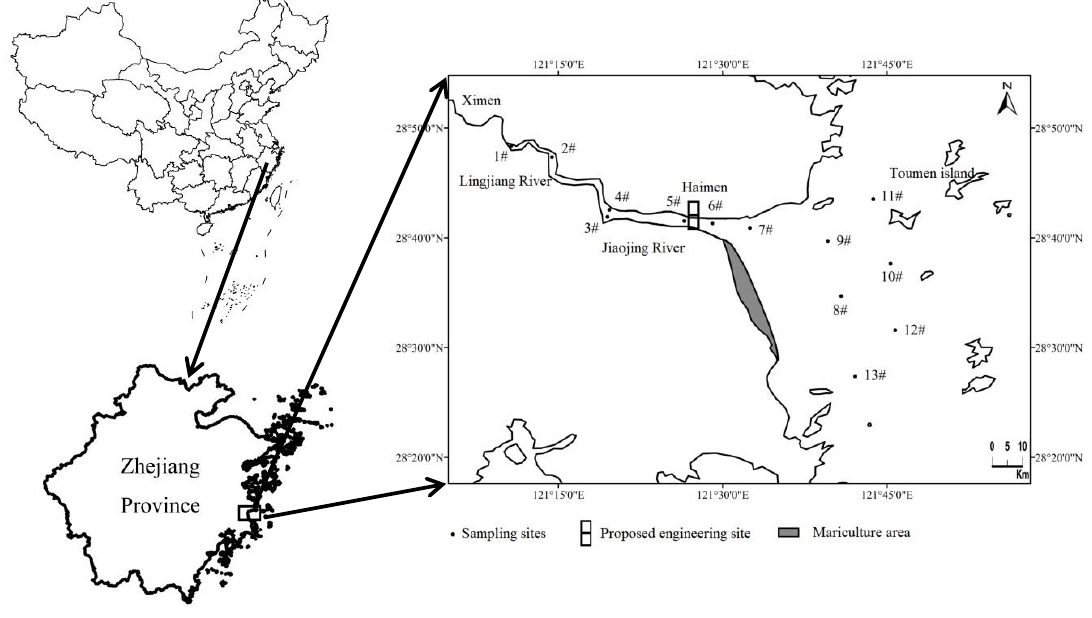
Figure 1. Sampling points proposed estuarine sluice site and aquaculture area location in the study area.